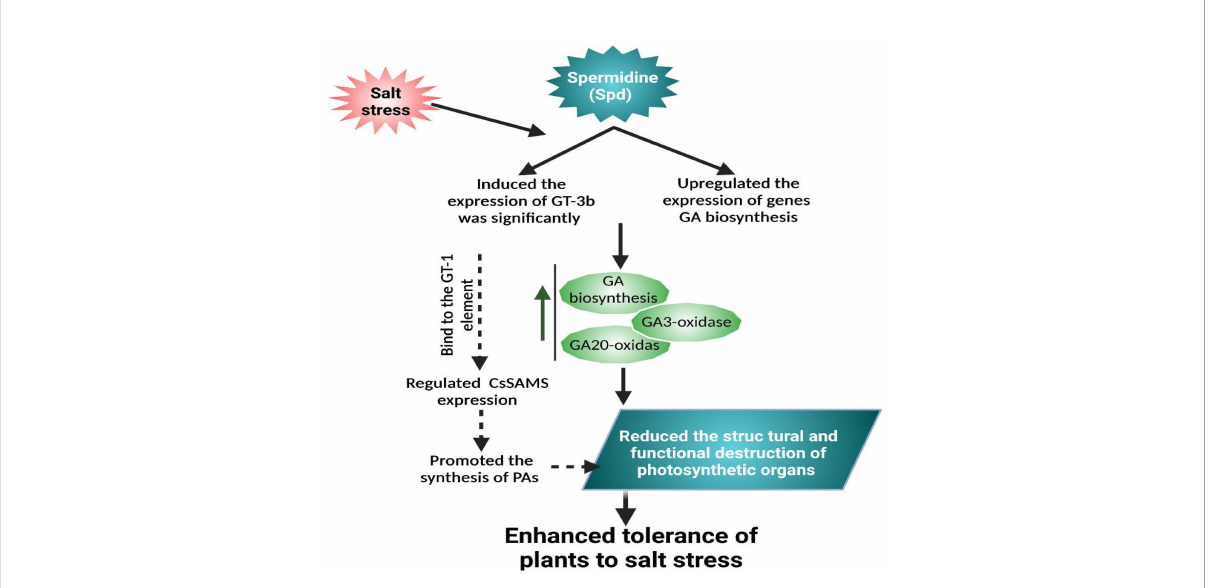
FIGURE 4 Exogenously applied Spd can improve salt tolerance. Spd-enhanced GT-3b expression level that is markedly related to endogenous GA content. Exogenous Spd signi fi cantly increased the content of endogenous GA3 under salt stress, upregulated the expression of genes related to GA biosynthesis, and enhanced the activity of GA3-oxidase and GA20-oxidase. GT-3b can bind to the GT-1 element in the promoter of the S- adenosylmethionine synthase gene (CsSAMS) to regulate CsSAMS expression in cucumber, which can promote the PA synthesis. The PA and phytohormones interplay alleviated the disruption of photosynthetic organs and promoted stress tolerance (Wang et al.,